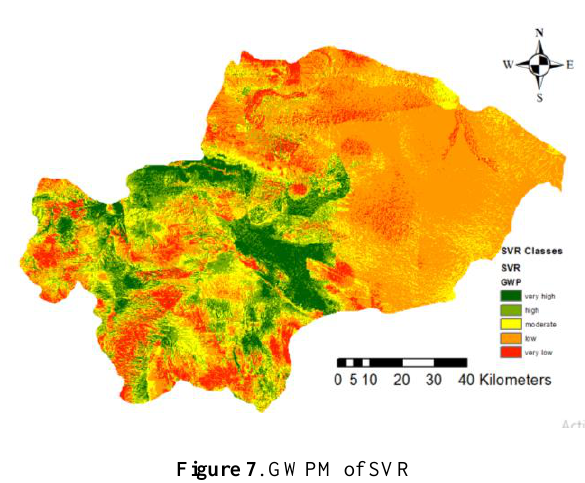
Figure 7 . GWPM of